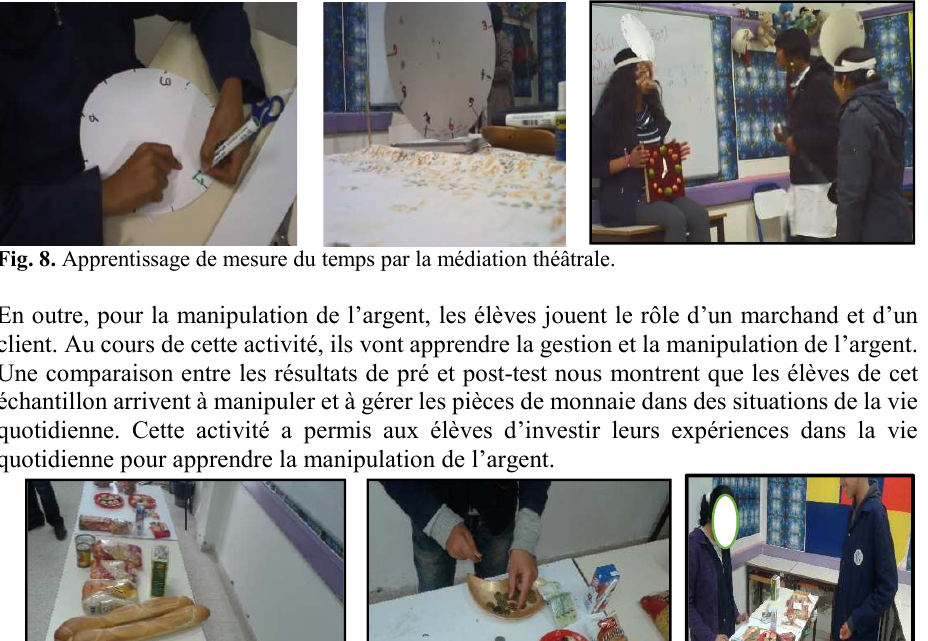
Fig. 9. Apprentissage de la manipulation de l’argent par la médiation théâtrale.